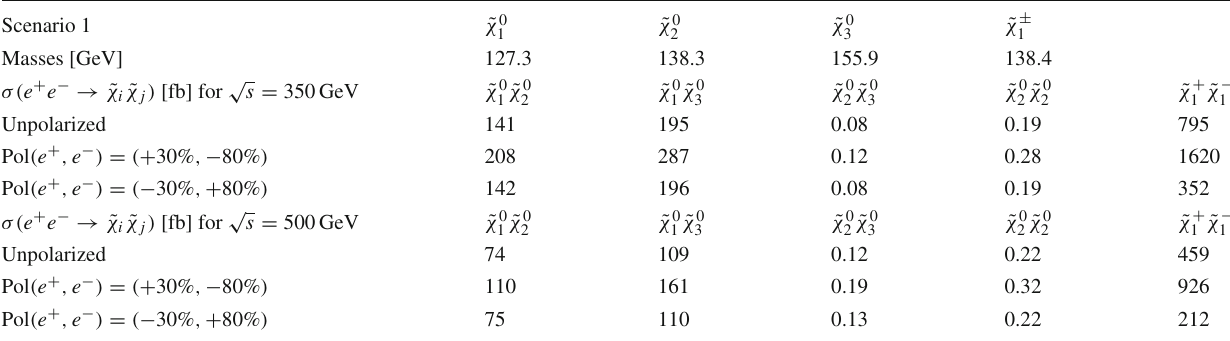
Table 3 Cross-sections for electroweakinos at an electron–positron collider for Scenario 1 defined in Table 2 Scenario